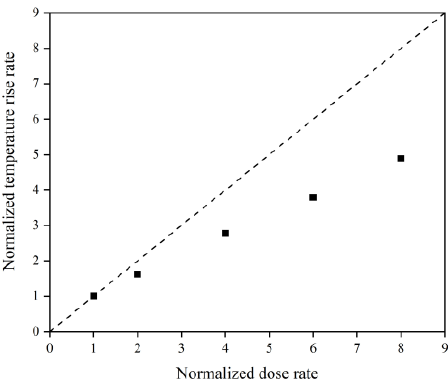
Figure 32. Normalized temperature rise rate of the Kapton under atomic oxygen impact with dif- Figure 31. Temperature variation of the Kapton under atomic oxygen impact with different dose ferent dose rates.